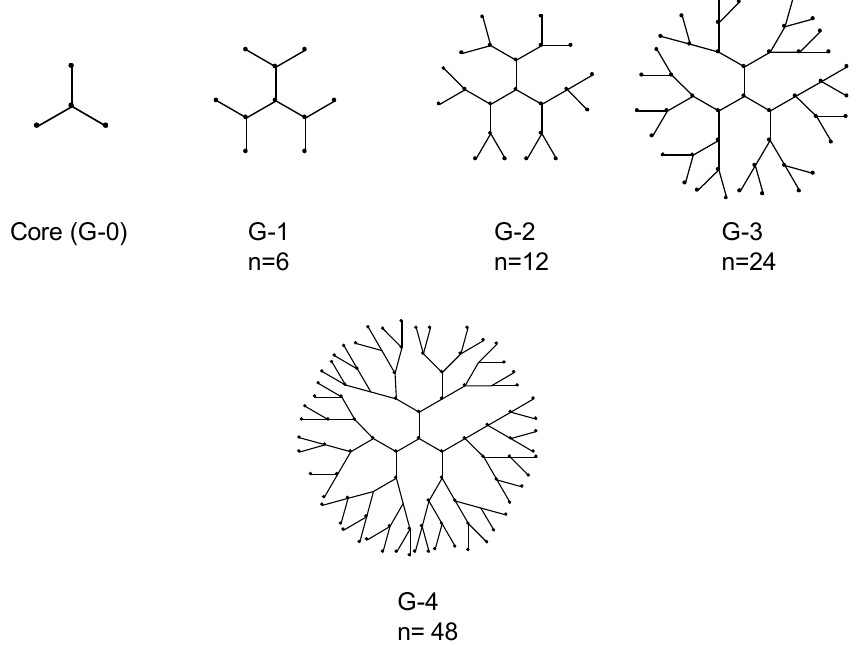
Figure 1. Representation of dendrimers of generations 1–4. The n denotes number of terminal functional